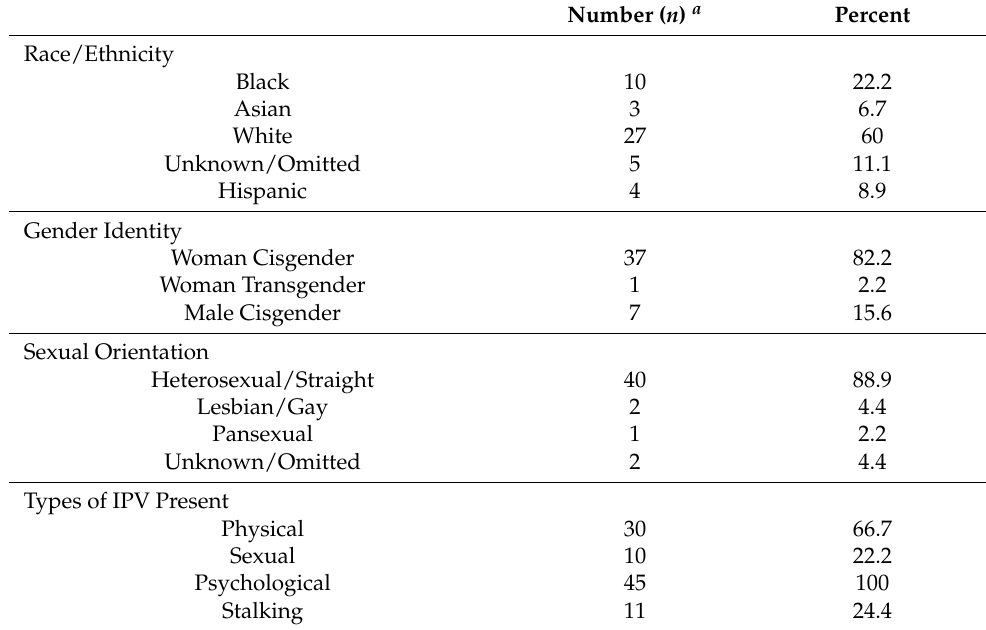
Table 2. Characteristics of the Sample ( N =